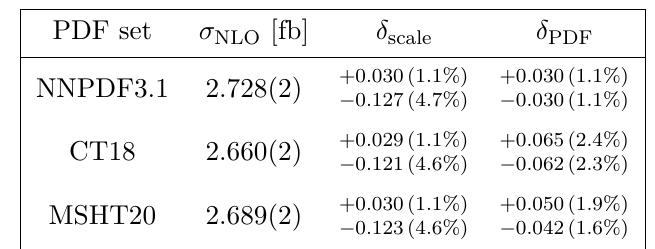
Figure 5 . Integrated fiducial cross section at NLO in QCD for the pp → e + ν e µ − ¯ ν µ b ¯ b H process √ at the LHC with s = 13 TeV. Results are presented for µ 0 = H T / 2 as well as for various PDF sets. Also given are internal PDF uncertainties. Scale uncertainties are reported for the NNPDF3.1 PDF set and are shown as a blue band.